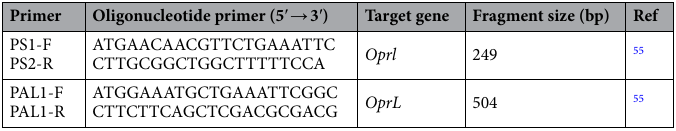
Table 5. Oligonucleotide primers used for the amplification of oprl and oprL